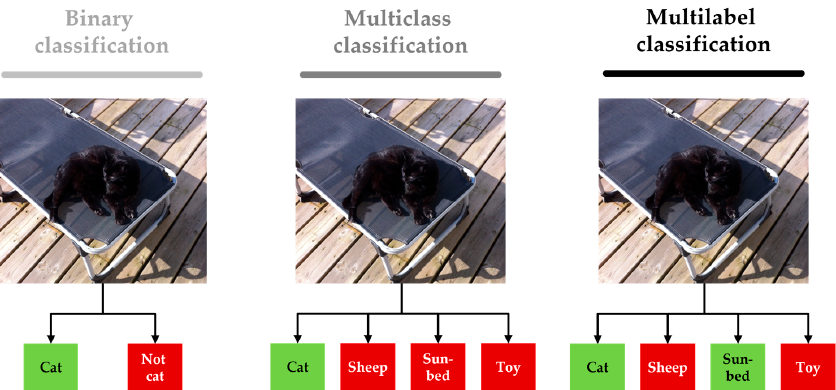
Figure 3. Comparison of different classification approaches according to [23,24] with positive classification results marked in green. cation results marked in